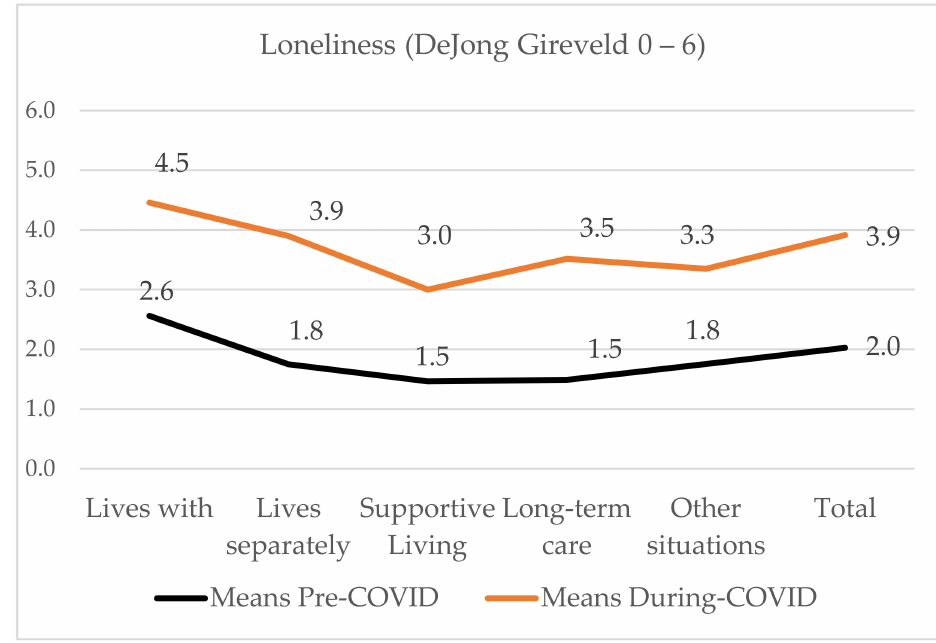
Figure 6. Mean loneliness by receivers’